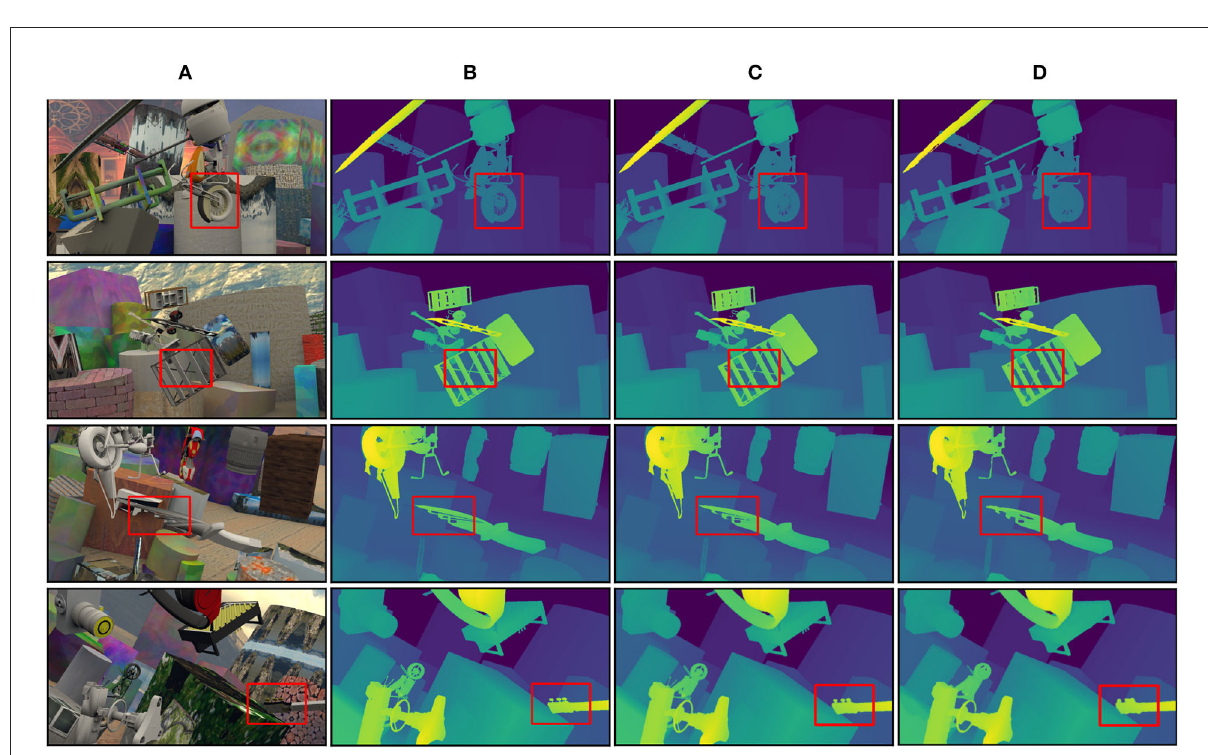
FIGURE6 Visualization on scene flow. (A) Left images, (B) ground truth, (C) LANet, and (D)